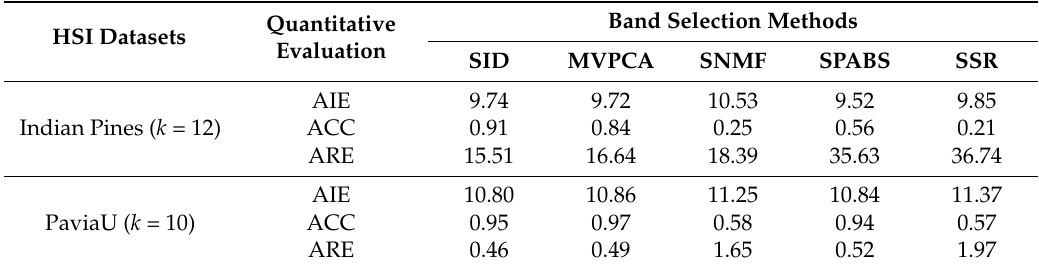
Band Selection Methods